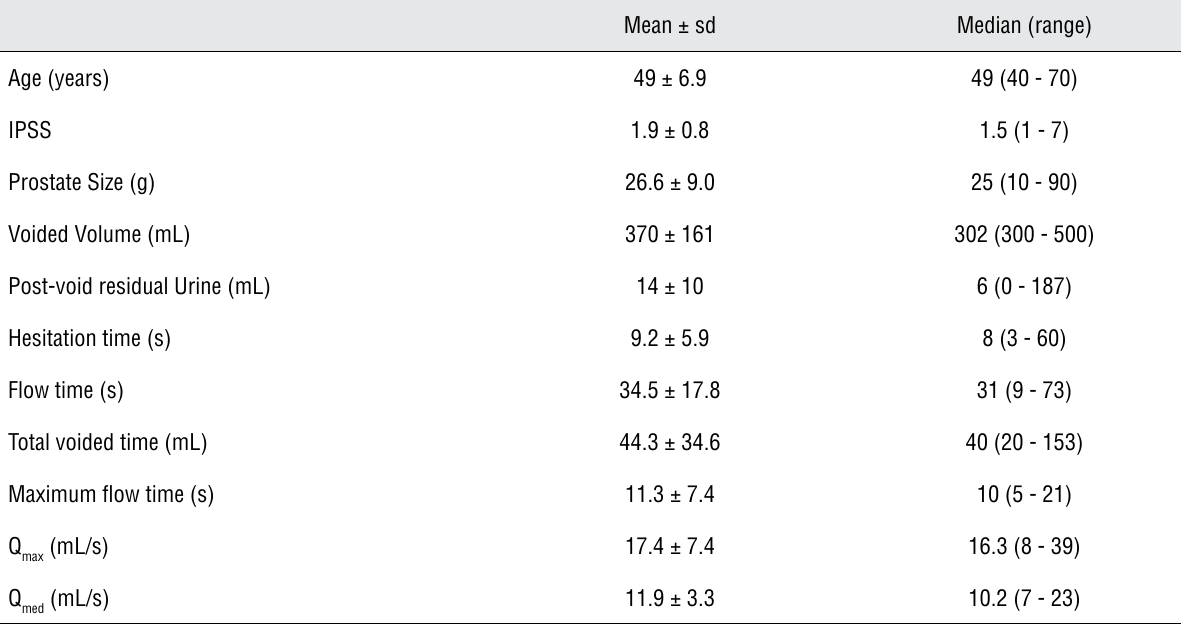
Table 1 - Demographics and uroflowmetry data of 1041 men submitted to a health check up program.